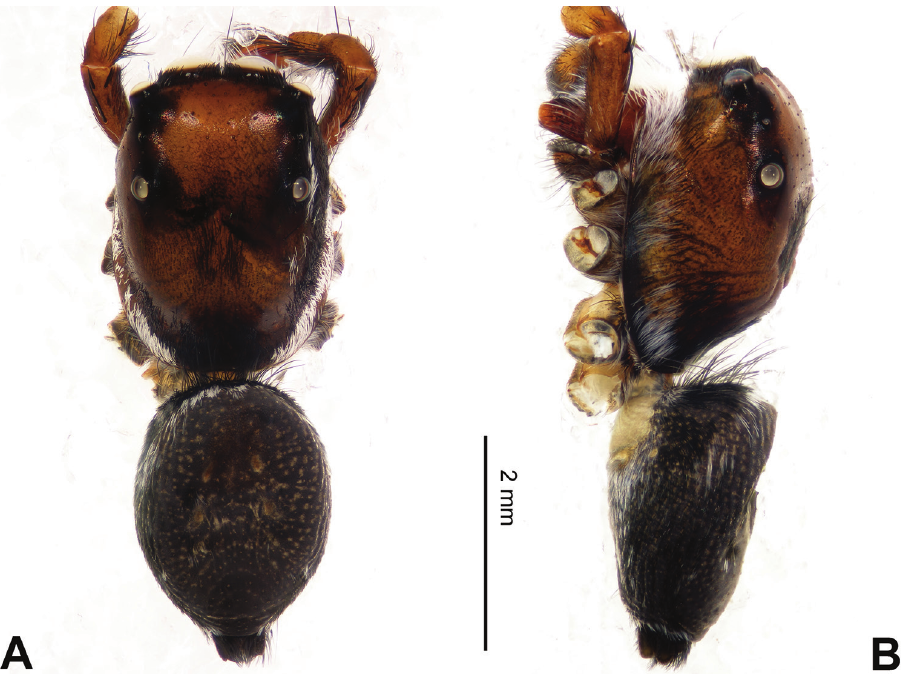
Figure 12. Habitus of Carrhotus sarahcrewsae sp. n., male holotype. A dorsal B lateral. Scale bar equal for A and B